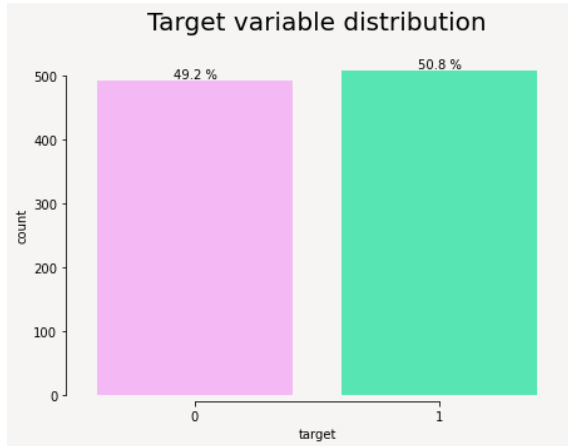
Figure 5. Heart disease target variable distribution.